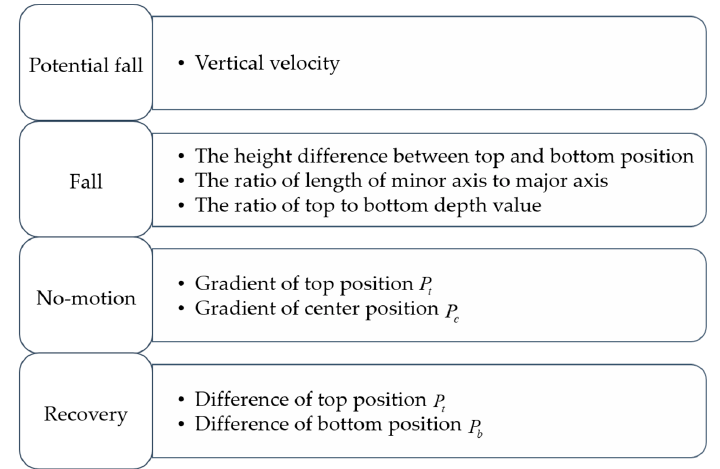
Figure 6. Adaptive features for accurate state classification.